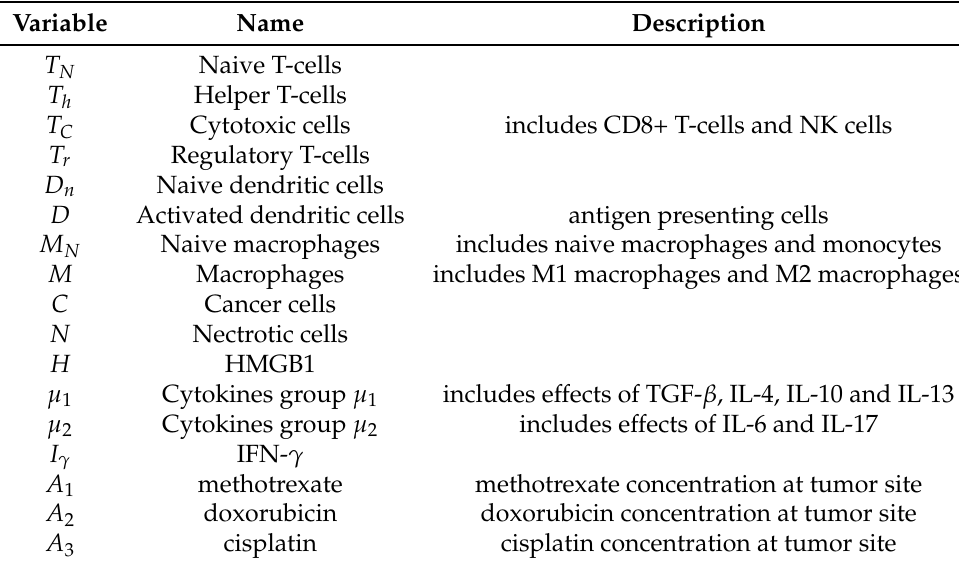
Table 1. Model Variables. Names and descriptions of the variables used in the model.